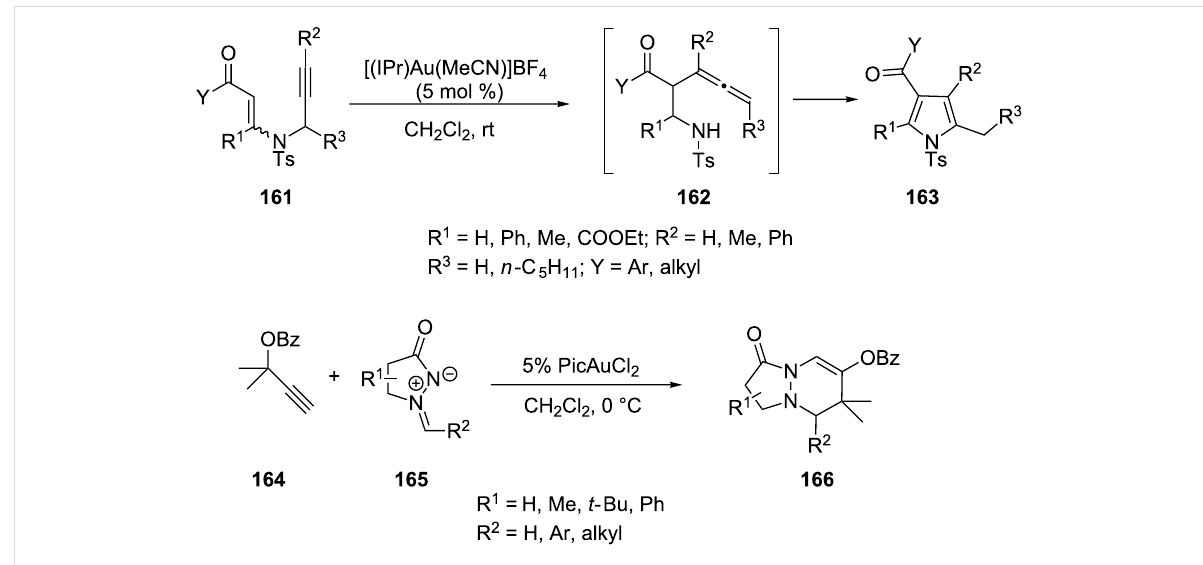
Scheme 29: Gold-catalyzed annulations of N -propargyl- β -enaminones and azomethine imines.